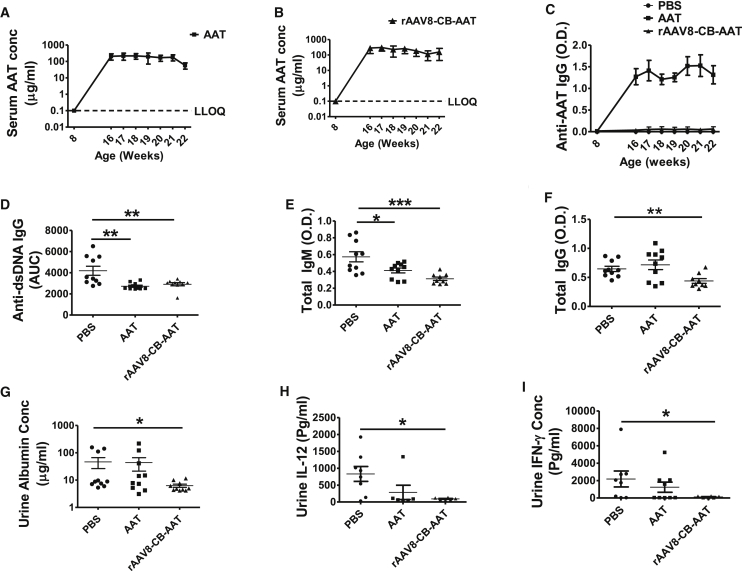
hAAT Inhibited Antibody Production and Proteinuria in NZM2410 Mice8-week-old female NZM2410 mice (N = 10) were treated with PBS, AAT, or rAAV8-CB-hAAT and sacrificed at 22 weeks of age. (A) Serum hAAT levels in the AAT protein-treated group. The dashed line shows the lower limit of quantification (LLOQ). Results from the PBS-treated group were below LLOQ and are not shown. (B) Serum hAAT levels in the rAAV8-CB-hAAT-treated group. (C) Serum anti-hAAT IgG levels in the hAAT- and rAAV8-CB-hAAT-treated groups. Results from the PBS-treated group were below LLOQ. (D) Serum anti-dsDNA IgG levels at 8 (prior treatments), 16, 17, 18, 19, 20, and 21 weeks of age were detected by ELISA. The area under the curve (AUC) for each animal was calculated, and the average of AUC for each group was plotted and analyzed (E and F) Serum levels of total IgM (E) and IgG (F) at 22 weeks of age. Data were expressed as the mean ± SEM and analyzed by one-way ANOVA using Tukey’s post hoc test corrections. (G–I) Detectable levels of urine albumin (G), IL-12 (H), and IFN-γ (I) levels at 22 weeks of age. PBS versus rAAV-CB-hAAT was expressed as the mean ± SEM and analyzed by two-tailed Mann-Whitney t test. *p < 0.05, **p < 0.01, and ***p < 0.001.